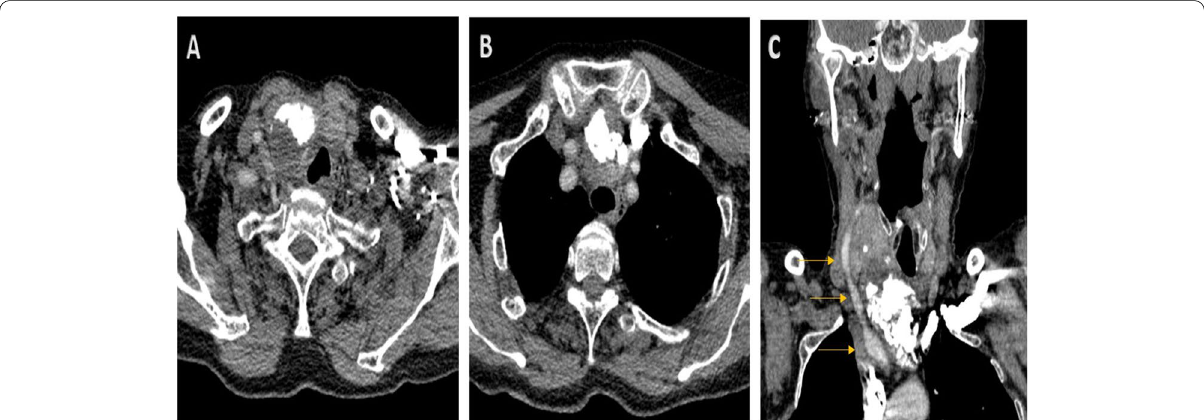
Fig. 2 Post-contrast neck and upper chest CT axial ( A , B ) and coronal images ( C ). Heterogenous enhancing right thyroid lobe soft tissue mass with coarse calcification is seen displacing the airway to the contralateral side and extending down to the superior mediastinum abutting the aortic arch branches with clear fat plane in-between. It was seen also contacting the right CCA along its length without vascular invasion (arrows). No pathological cervical